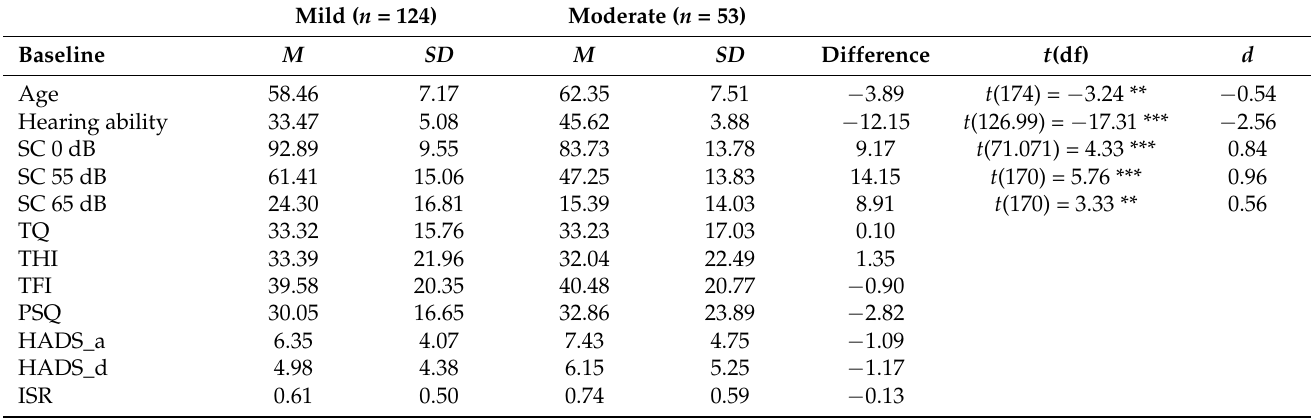
Table 2. Descriptive indices for patients with mild ( n = 124) vs. moderate hearing loss ( n =